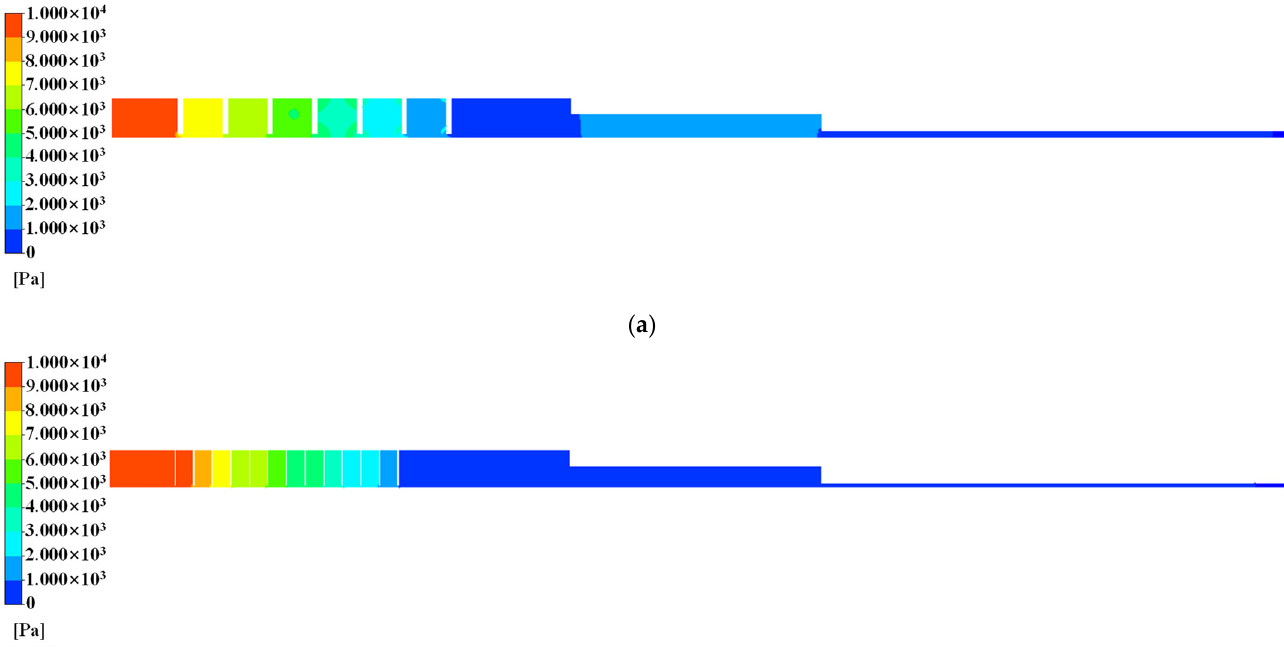
( c ) Figure 9. Pressure distribution diagram of three types of seals (REL = 0.1 mm). ( a ) Labyrinth seal; ( b ) honeycomb seal; ( c ) hybrid labyrinth–honeycomb seal.